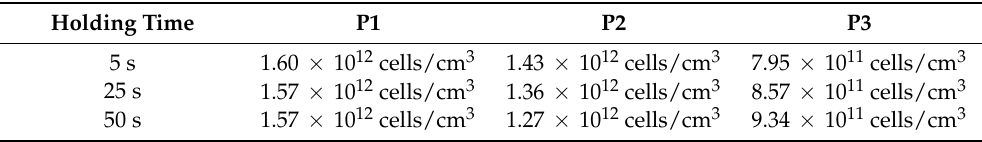
Table 8. Averaged cell density at different GCP holding times (SCF 0.7%wt, GCP 5